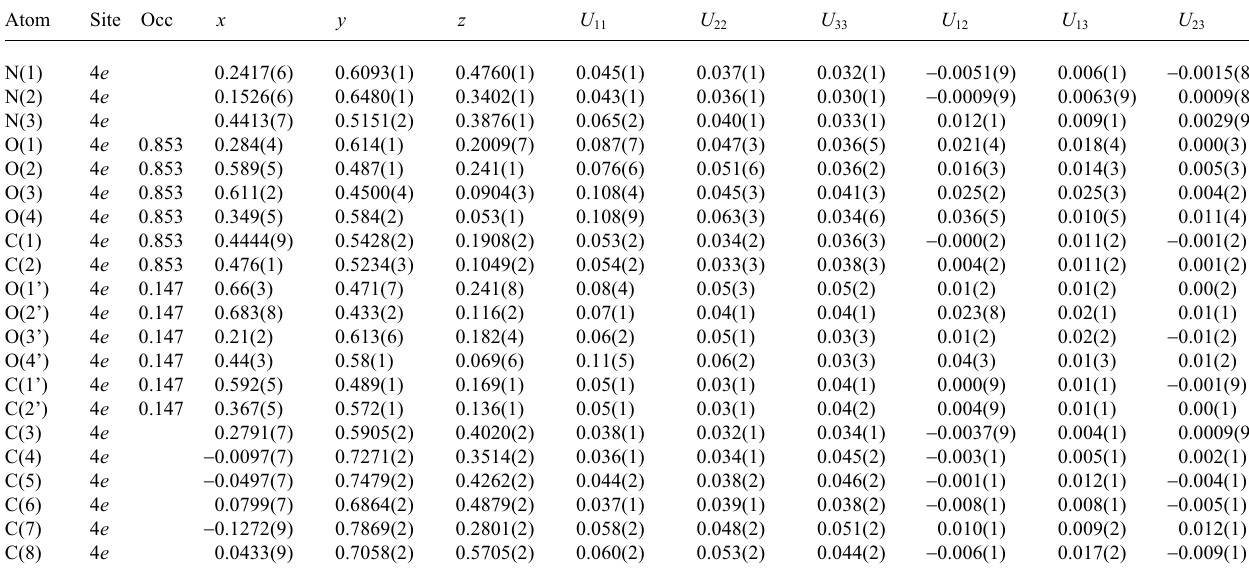
Table 3. Atomic coordinates and displacement parameters (in Å 2 )